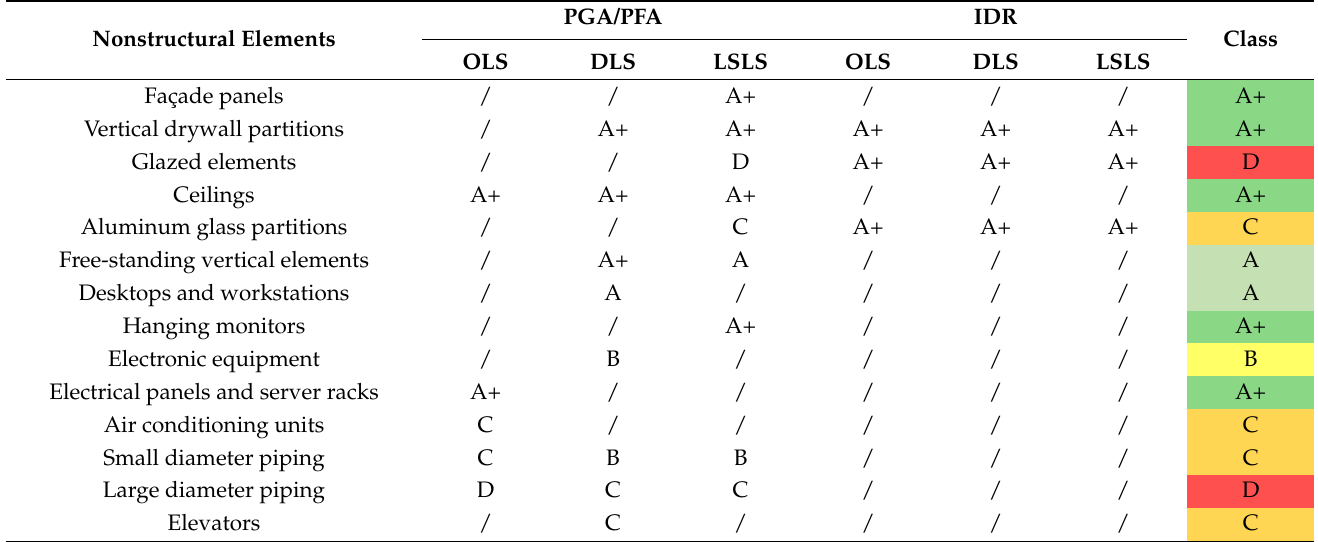
Table 14. Seismic risk classes for the nonstructural elements of the second application case